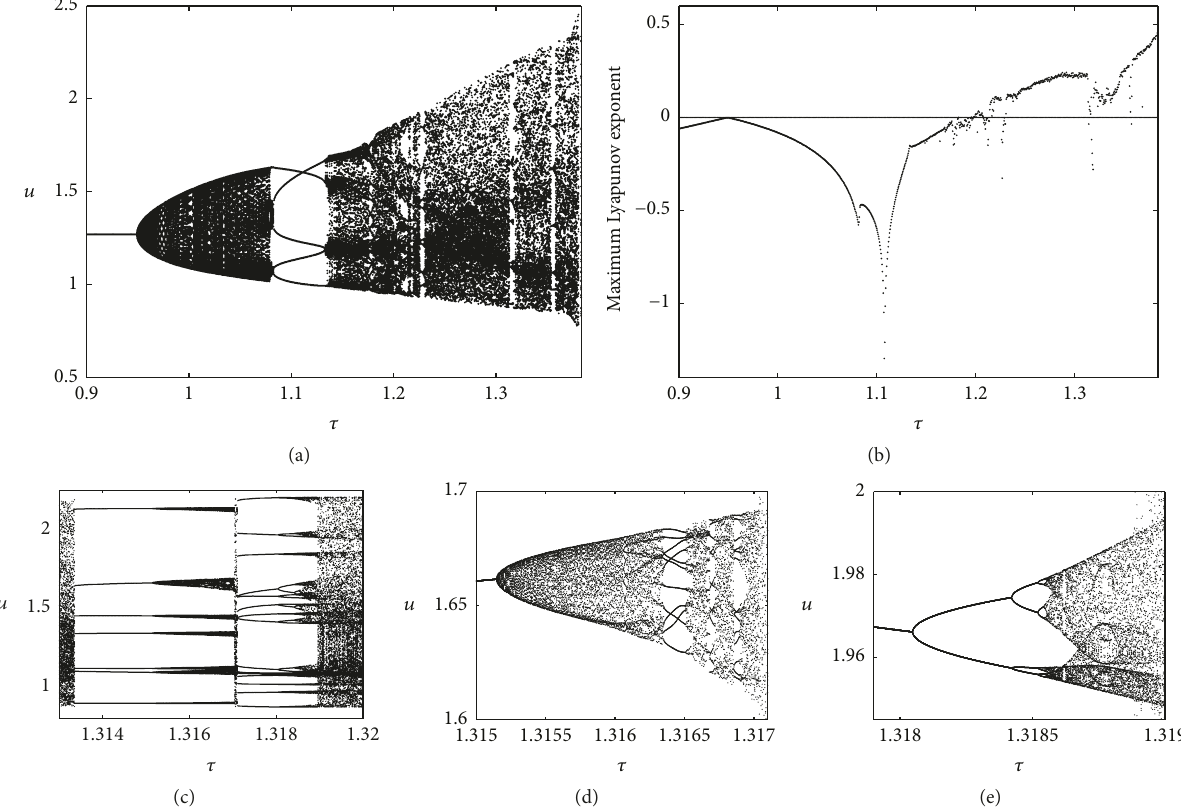
Figure 5: (a) Neimark-Sacker bifurcation diagram with parametric conditions given as 𝑎 = 2 , 𝑏 = 2 , 𝑐 = 2 , 𝑑 = 1.85 , 𝛼 = 0.1 , and 𝛽 = 0.1 ; (b) maximum Lyapunov exponent corresponding to (a); (c) local amplification of (a) in the range of [1.313, 1.32] ; (d)-(e) amplifications of sub-Neimark-Sacker bifurcation and sub-flip bifurcation diagrams on each branch of periodic